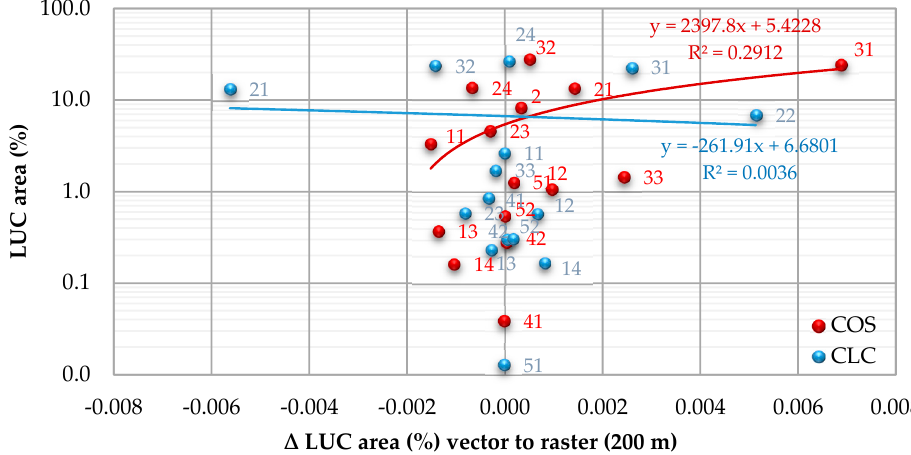
Figure 7. Relationship between LUC area (average area of vector GI: COS 2007, COS 2010; and CLC 2006, CLC 2012) and LUCC area (gains) variation obtained between vector and raster (resolution 200 m). See LUC legend (numbers) in Figure 1.